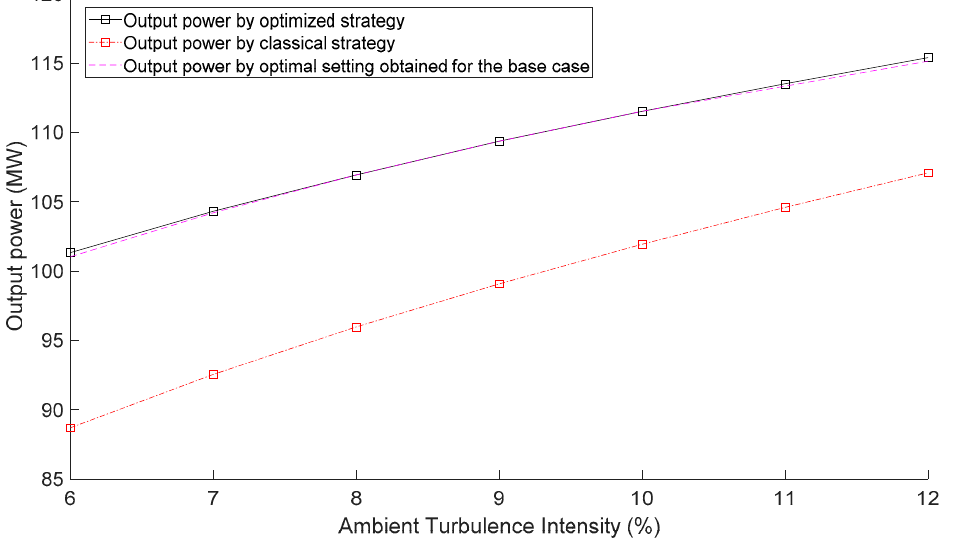
Figure 11. Sensitivity analysis as a function of the ambient turbulence intensity. Figure 12 shows the sensitivity analysis performed against the variation of the in- coming wind direction angle (keeping the wind speed constant 9 m/s and the turbulence intensity constant 8%). In this analysis, the base case (where the angle of the incoming wind direction on the horizontal axis is 0°) has been initially considered and the angle has been increased up to a maximum value of 10° with respect to the horizontal axis (please note that as the WTs layout is symmetrical with respect to the horizontal axis, the analysis shown in the figure is equivalent for the case of negative angles of the incoming wind direction).